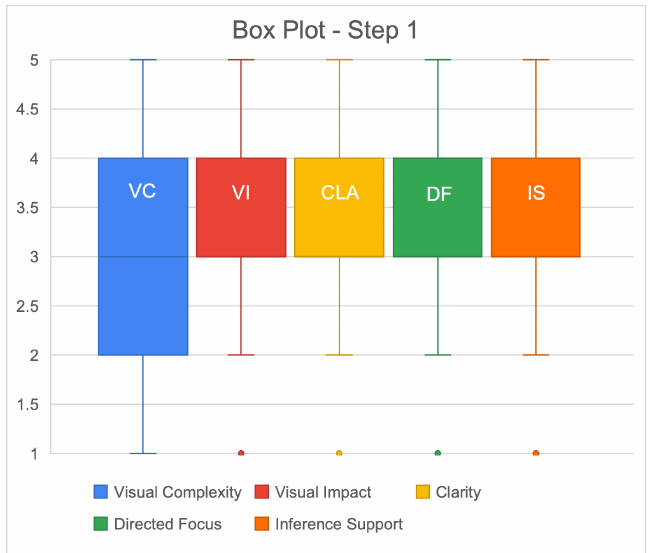
Figure 5. Boxplot chart for the results associated with the visual characteristics of Step 1 instructions— push the cables to the side to make